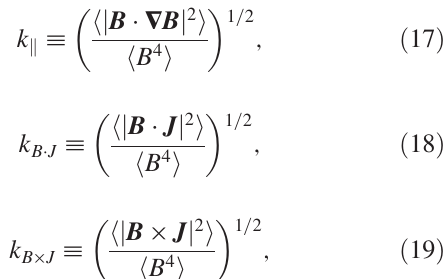
FIG. 6. (a) Angle-integrated kinetic E ð k Þ (dashed) and magnetic M ð k Þ (solid) spectra, time averaged over the saturated state of runs d1, d2, d3, and d4 ( 2240 3 at different Pm), normalized by ρ 0 u 2 The magnetic-energy spectrum steepens to be consistent with the predicted − 19 = 9 envelope for a tearing-mediated cascade at a wave number that increases slightly with Pm; cf. Eq. (10), which predicts λ − 1 ∝ Pm 1 = 5 at fixed Rm when n ¼ 2 . The arrows indicate the (cid:2) for Pm ¼ 10 (purple) and 100 (yellow). (b) Kinetic predicted λ − 1 (cid:2) spectra compensated by k 5 = 3 , and magnetic spectra compensated curves.FIG. 5. Angle-integrated spectra for Pm ¼ 10 at different by k , to illustrate the argument made at the end of Sec. III D; here, resolutions (runs a2, b2, c2, and d2). Color coding of lines is kM ð k Þ is multiplied by an arbitrary factor of 0.1 to separate it the same in all panels. (a) Kinetic E ð k Þ (dashed) and magnetic visually from the other M ð k Þ (solid) energy spectra at the end of the kinematic stage, normalized by ρ 0 u 2 . The spectral peak of the magnetic energy rms ; sat depends on the resolution. (b) Kinetic E ð k Þ (dashed) and magnetic- M ð k Þ (solid) energy spectra normalized by ρ 0 u 2 , rms ; sat time averaged over the saturated state. The arrows indicate the [see Eq. (10)] for Pm ¼ 10 at predicted field-reversal scale λ − 1 (cid:2) 1120 3 (purple) and 2240 3 (black). The magnetic-energy spectrum , which acquires a slope steeper than − 5 = 3 starting at k= 2 π ∼ λ − 1 (cid:2) at 2240 3 is consistent with the spectral envelope of k − 19 = 9 expected for a tearing-mediated cascade. The spectral peak of the magnetic energy appears to be independent of Rm. (c) Trans- fer function T ð k Þ in saturation, normalized by ρ 0 u 3 , with rms ; sat filled (open) circles corresponding to work done by (against) the Lorentz